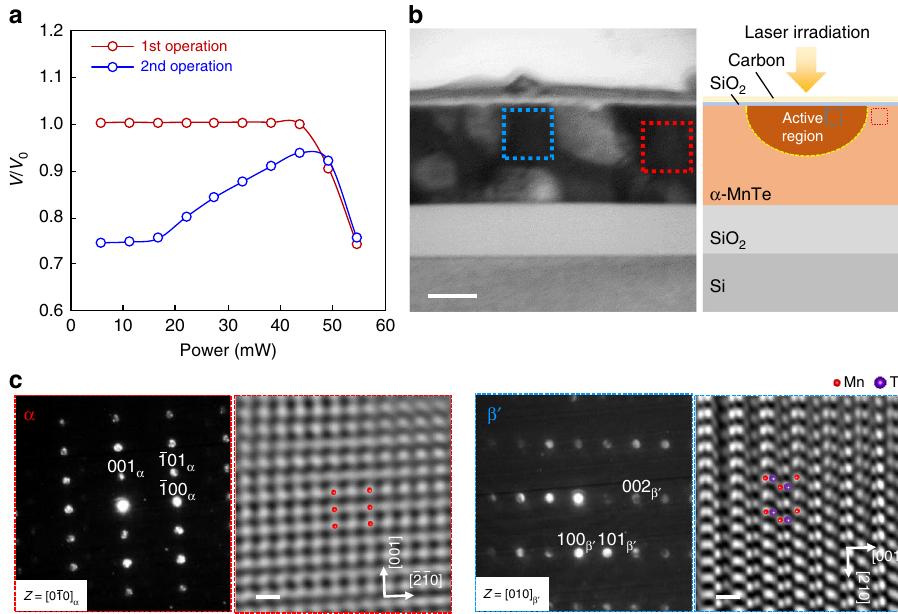
Fig. 5 Re fl ectance change in the MnTe fi lm induced by laser irradiation. a Re fl ectance change behavior in the MnTe fi lm, induced by laser irradiation, as a function of pump laser power. V/V 0 corresponds to the normalized re fl ectance detected by a photodiode. First, the α -MnTe fi lm was irradiated with the pump pulse laser at the same position and its power was gradually increased. After the re fl ectance dropped, the laser power returned to zero and then again gradually increased, irradiating at the same position than the fi rst measurement. b Cross-sectional transmission electron microscopy (TEM) image of the MnTe fi lm that showed a re fl ectance decrease by laser irradiation. Scale bar: 100 nm. Schematic of the cross-section of the MnTe fi lm is shown in right inset. Only a small part near surface is supposed to be active region. c Selected area diffraction patterns (SADPs) and inverse fast Fourier transform (IFFT) images of high-resolution TEM (HR-TEM) images taken from α -matrix enclosed by the red-dotted line (left) and active region enclosed by the blue-dotted line (right). Scale bar: 5 Å . The active region exhibits a β ′ -phase. In the IFFT images, both Mn and Te atoms were observed in the β ′ -phase, whereas only Mn atoms were visible in the α -phase. Both images were well fi tted with the simulation results at a fi lm thickness of t = 9.9 nm and defocus Δ f = + 2 (see Supplementary Fig. 8a,